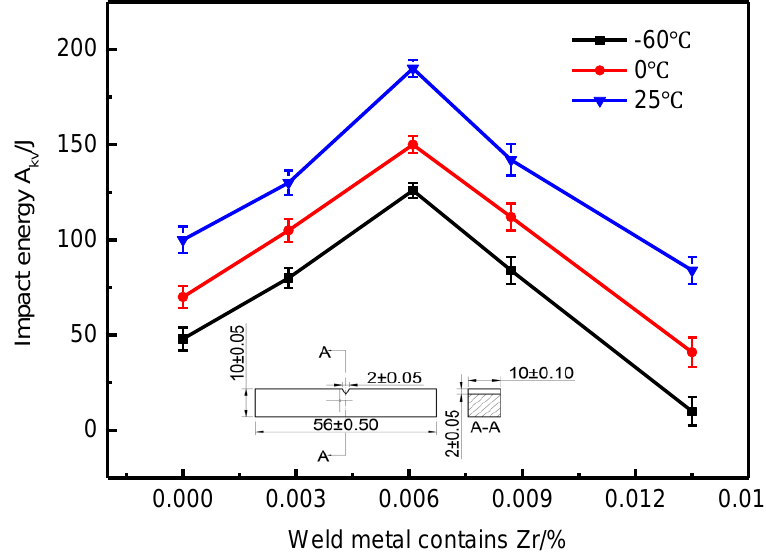
Figure 13. E ff ect of Zr contents on impact energy of weld Figure 13. Effect of Zr contents on impact energy of weld metal.